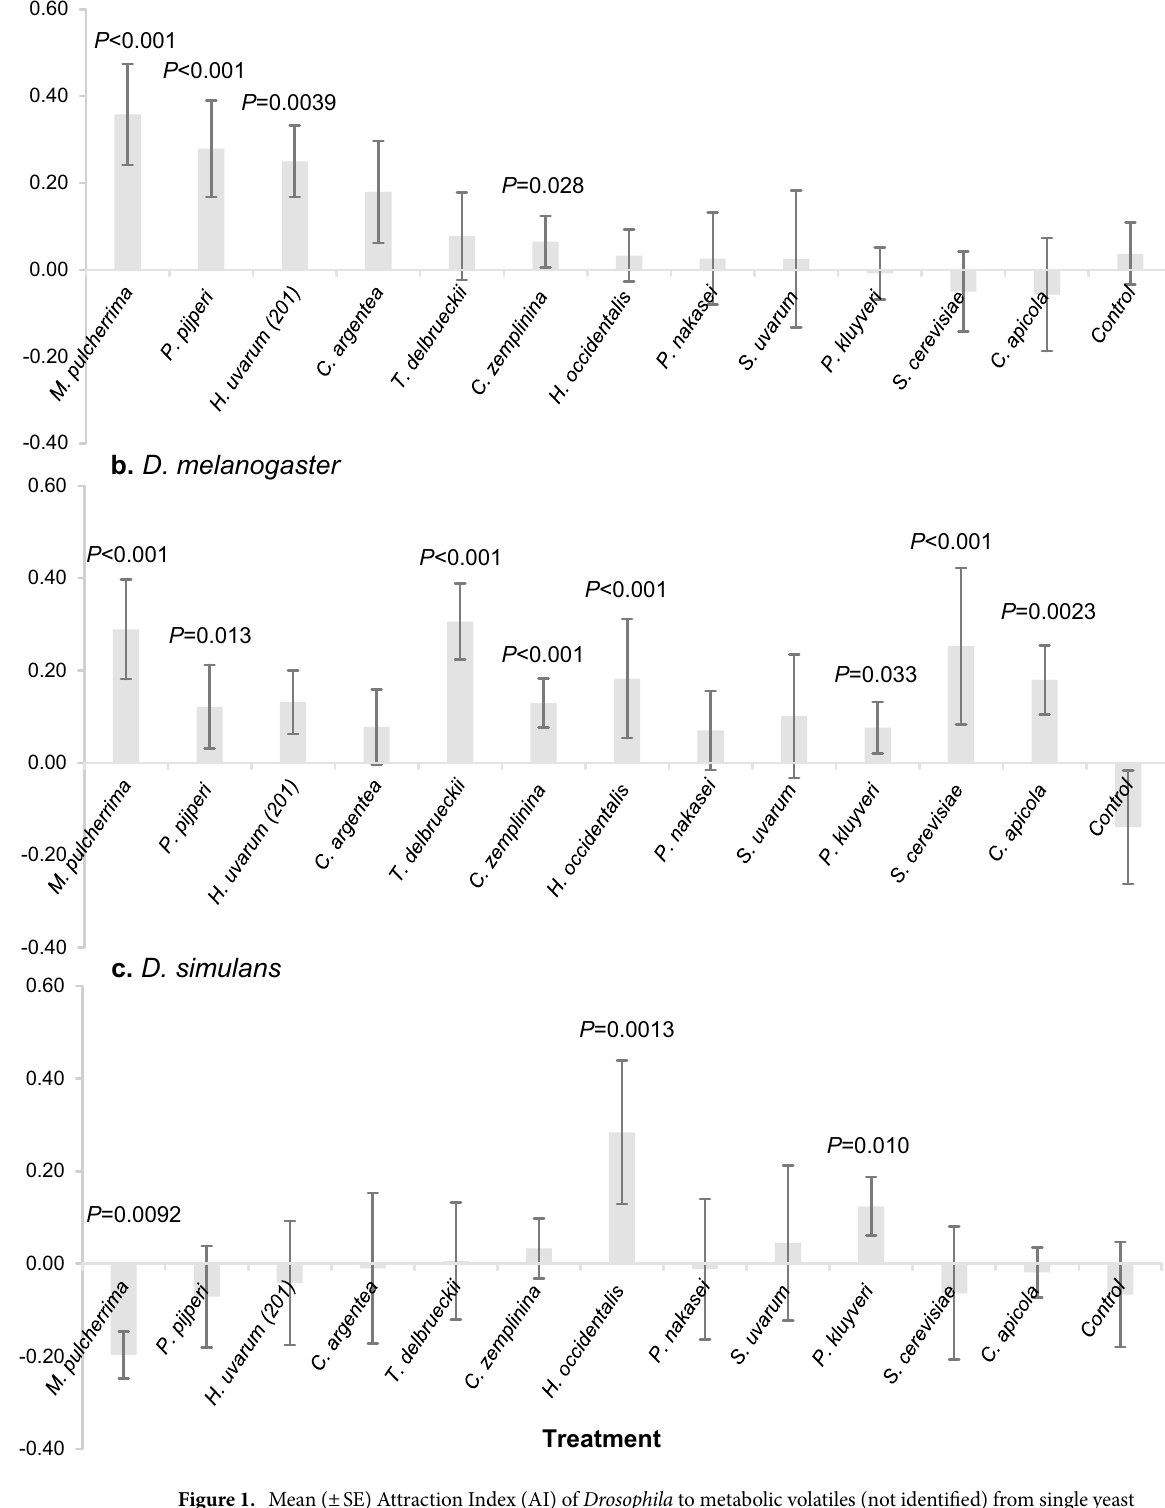
Figure 1. Mean (± SE) Attraction Index (AI) of Drosophila to metabolic volatiles (not identified) from single yeast isolates grown in sterile strawberry juice using laboratory T-mazes; control contains no yeast. ( a ) D. suzukii (N = 6 except P. kluyveri and C. zemplinina N = 18, N = 9 control) . ( b ) D. melanogaster (N = 6 except P. kluyveri N = 28 and C. zemplinina N = 24, control N = 9) . ( c ) D. simulans (N = 6 except P. kluyveri , C. zemplinina N = 18 and control N = 8). P-values above bars show significant attraction or repulsion to yeast volatiles over sterile strawberry juice in the opposing T-maze arm revealed by binomial analyses. The numbers of individuals that remained in the central compartment of the T-maze apparatus differed significantly between Drosophila species (binomial logistic regression, Δ deviance = − 741.03, df = − 2, P < 0.001; mean 69% D. suzukii , 42% D. melanogaster and 62% D. simulans